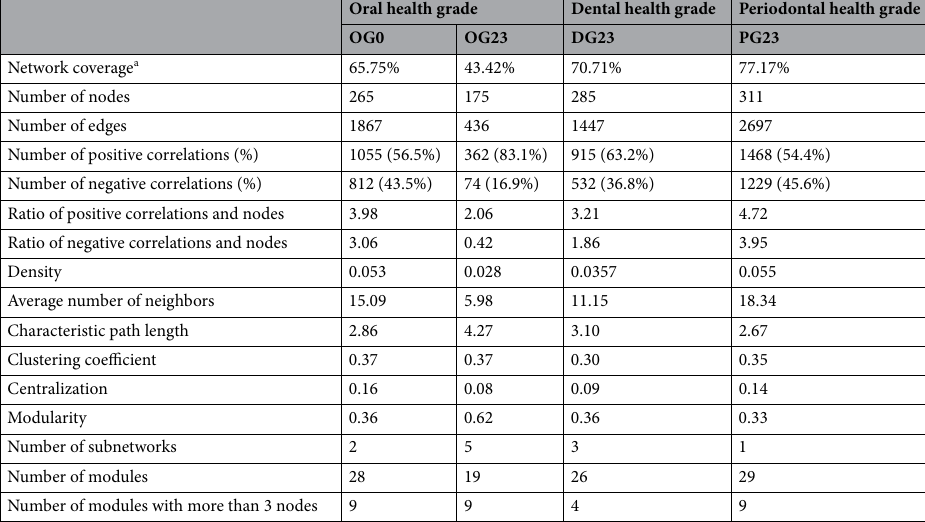
Table 6. Topological parameters of the co-occurrence networks in the different grades of the dental and periodontal subscales, as well as oral health scale. a Percentage of OTUs present in the co-occurrence network with respect to the total number of